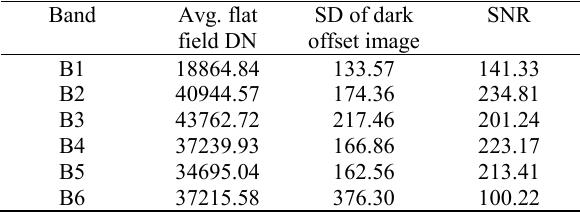
Table 2. The results of signal-to-noise